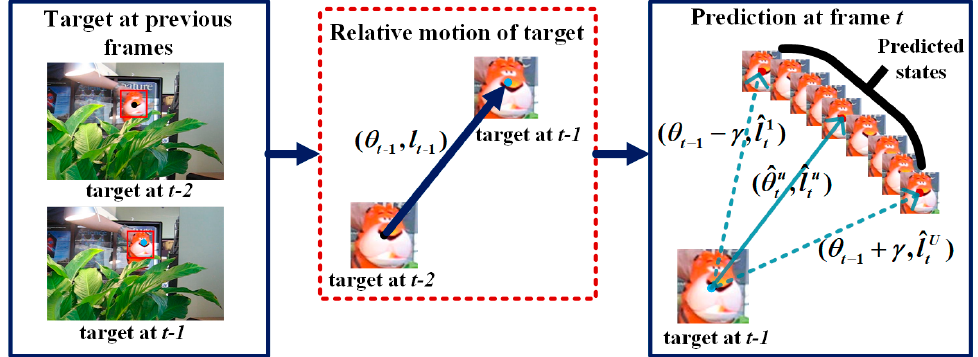
Figure 2. The relative motion of target in the previous frame including motion direction and motion distance is already known. Then the target motion direction in the current frame is predicted by adding a prediction range of γ to the previous motion direction, and the motion distance is predicted according to the previous motion distance with variation rate.